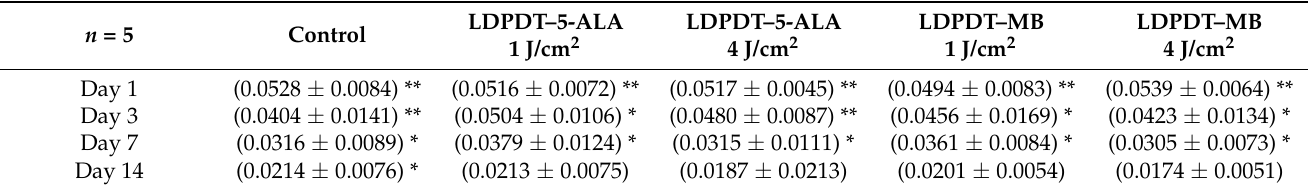
Table 1. CPF values for the studied groups (mean ± standard deviation).